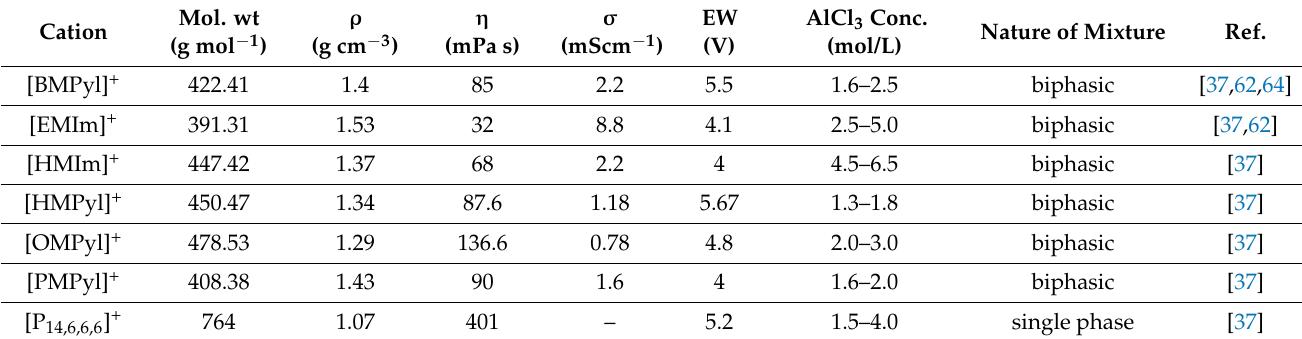
Nature of Mixture